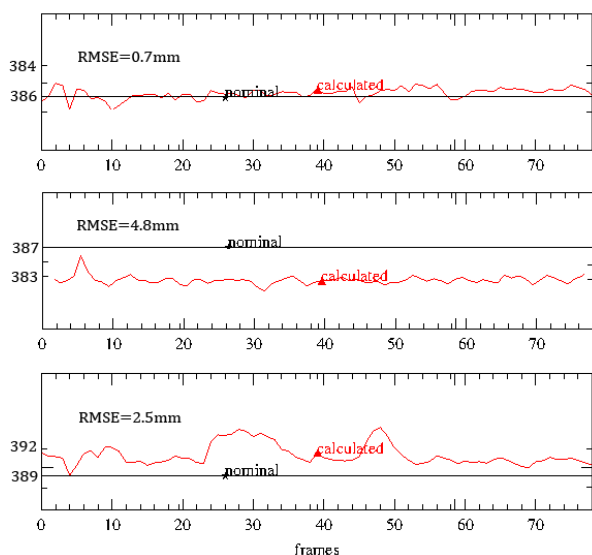
Figure 6: Evaluation of the results with dynamic referenc- ing. The diagrams show discrepancies of three scale bars (top,middle,bottom) between their reconstructed and their nomi- nal values, over duration of 70 frames. The lengths are given in